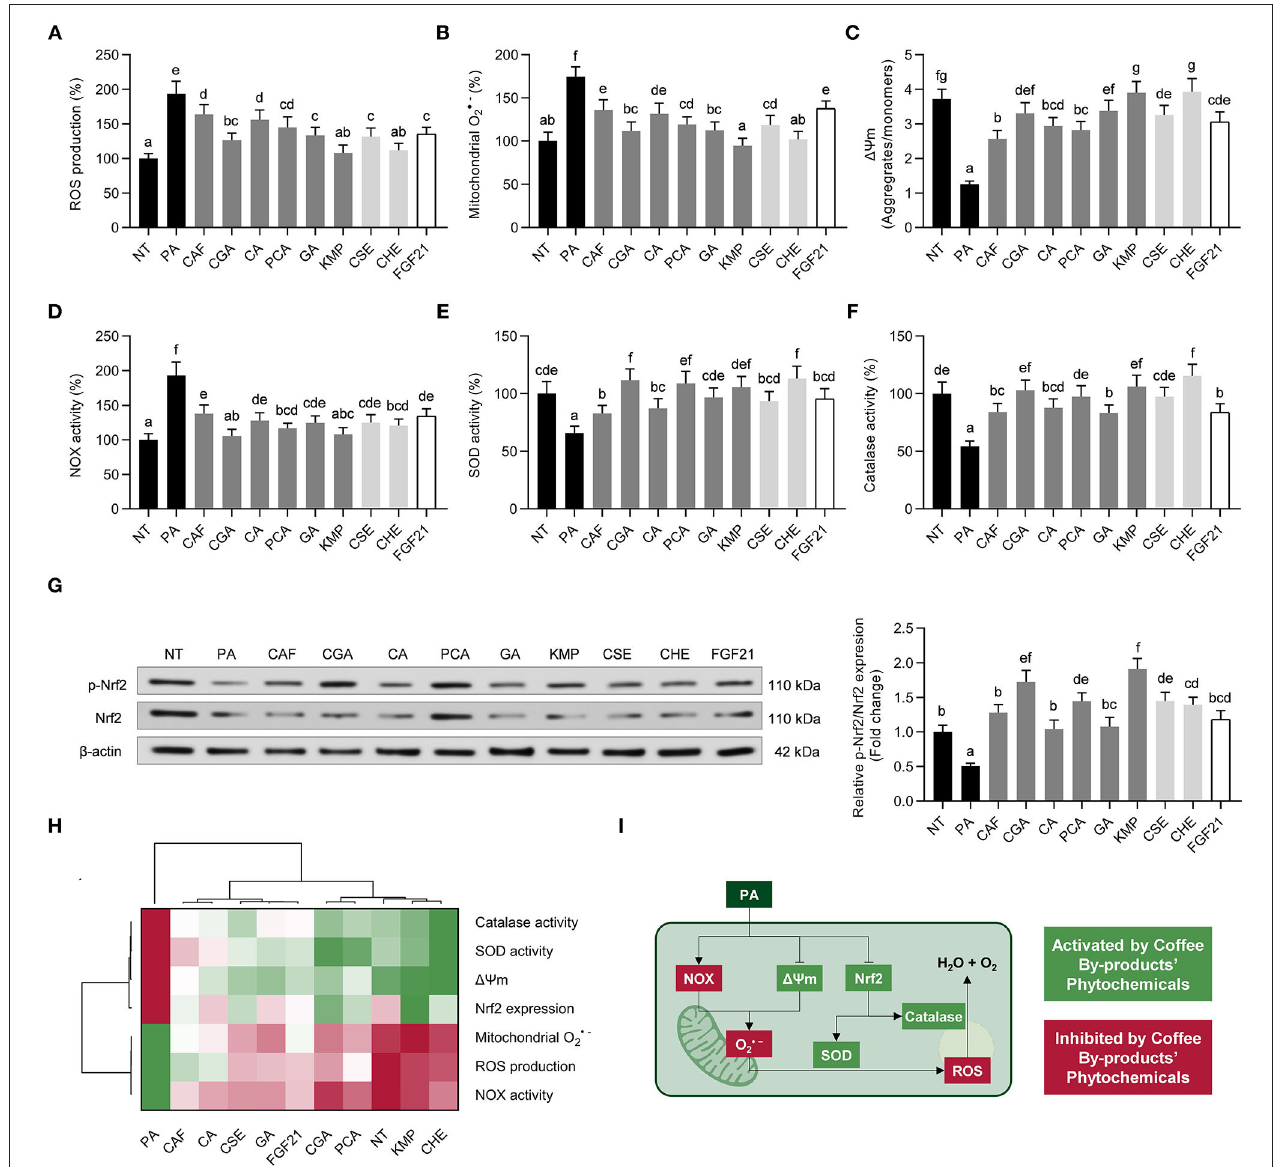
FIGURE 5 | Protective effects of standard solutions of the bioactive compounds from coffee by-products (50 µ mol L − 1 ), aqueous extracts (CSE and CHE, 100 µ g mL − 1 ), and FGF21 (20 nmol L − 1 ), in the presence of palmitic acid (PA, 500 µ mol L − 1 ) against oxidative stress in HepG2 human hepatocytes. Coffee by-products’ bioactive compounds diminished the production of reactive oxygen species (ROS) (A) and mitochondrial O •− 2 (B) , preserving the mitochondrial membrane potential ( 19 m) (C) in PA-challenged HepG2 cells. The enzymatic activity NADPH oxidase (NOX) (D) , superoxide dismutase (SOD) (E) , and catalase (F) activities, and nuclear factor (erythroid-derived 2)-like 2 (Nrf2) phosphorylation (G) were regulated, thereby diminishing oxidative stress. Hierarchical cluster analysis and heat map [from the lowest ( (cid:4) red) to the highest ( (cid:4) green) value for each parameter] (H) and an integrative diagram illustrating the effects of the bioactive compounds from coffee by-products on oxidative stress (I) . The results are expressed as mean ± SD ( n = 3). Bars with different letters significantly ( p < 0.05) differ according to ANOVA and Tukey’s multiple range test. NT, non-treated cells; CAF, caffeine; CGA, chlorogenic acid; CA, caffeic acid; PCA, protocatechuic acid; GA, gallic acid; KMP, kaempferol; FGF21, fibroblast growth factor